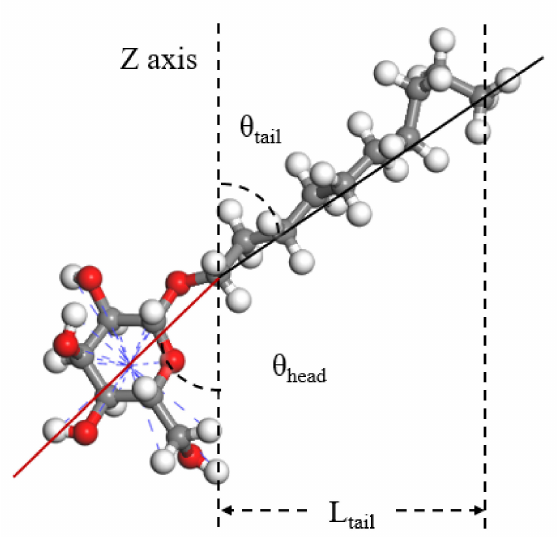
Figure 16. Definition of the tilt angle of head groups ( θ head ) and tail groups ( θ tail ) and the length of tail groups (L tail ).